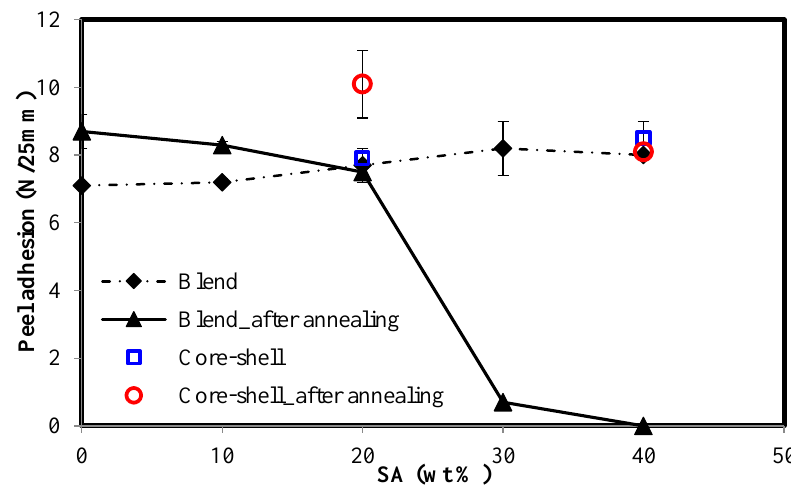
Figure 4. Effect of annealing of adhesives already bonded to stainless steel on peel adhesion.